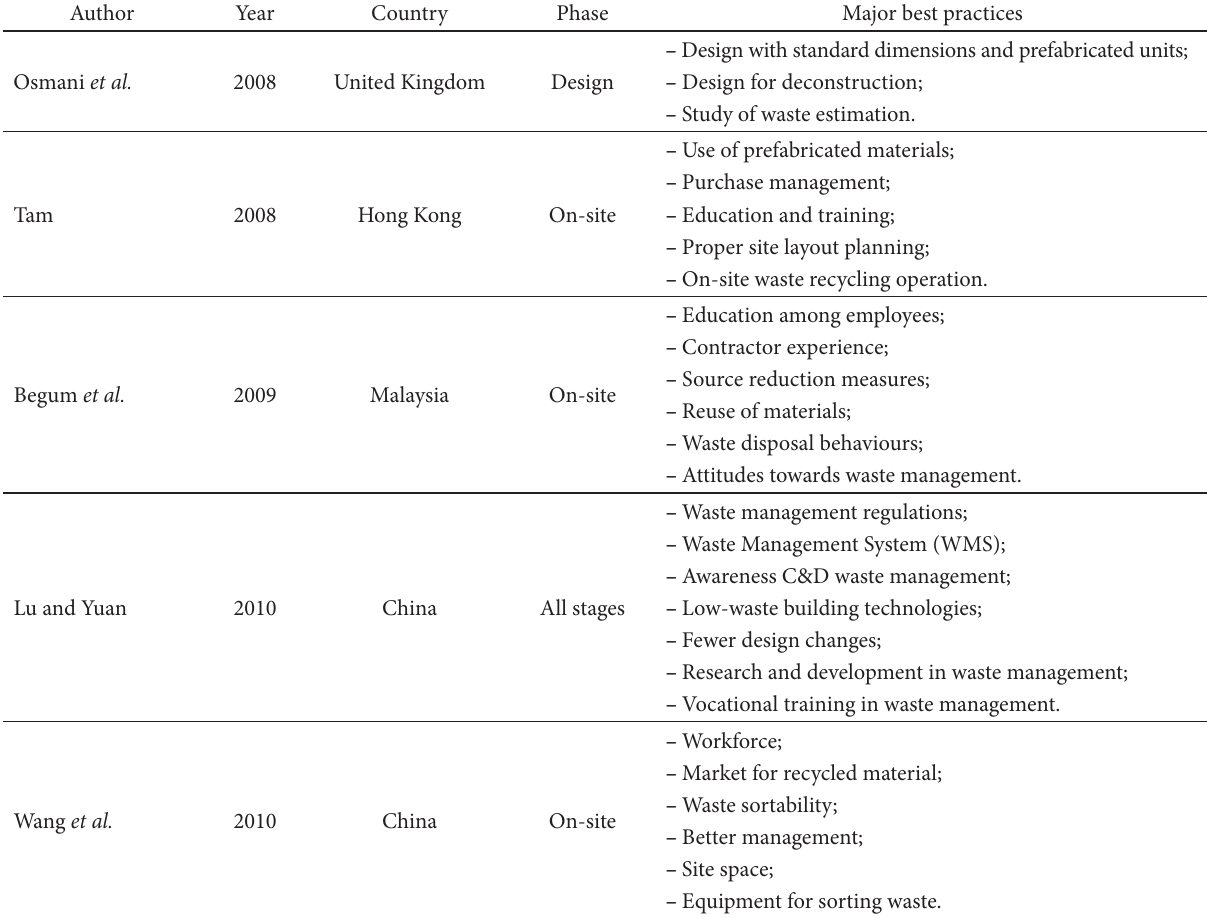
Table 1. Previous studies regarding best practices for C&D waste management